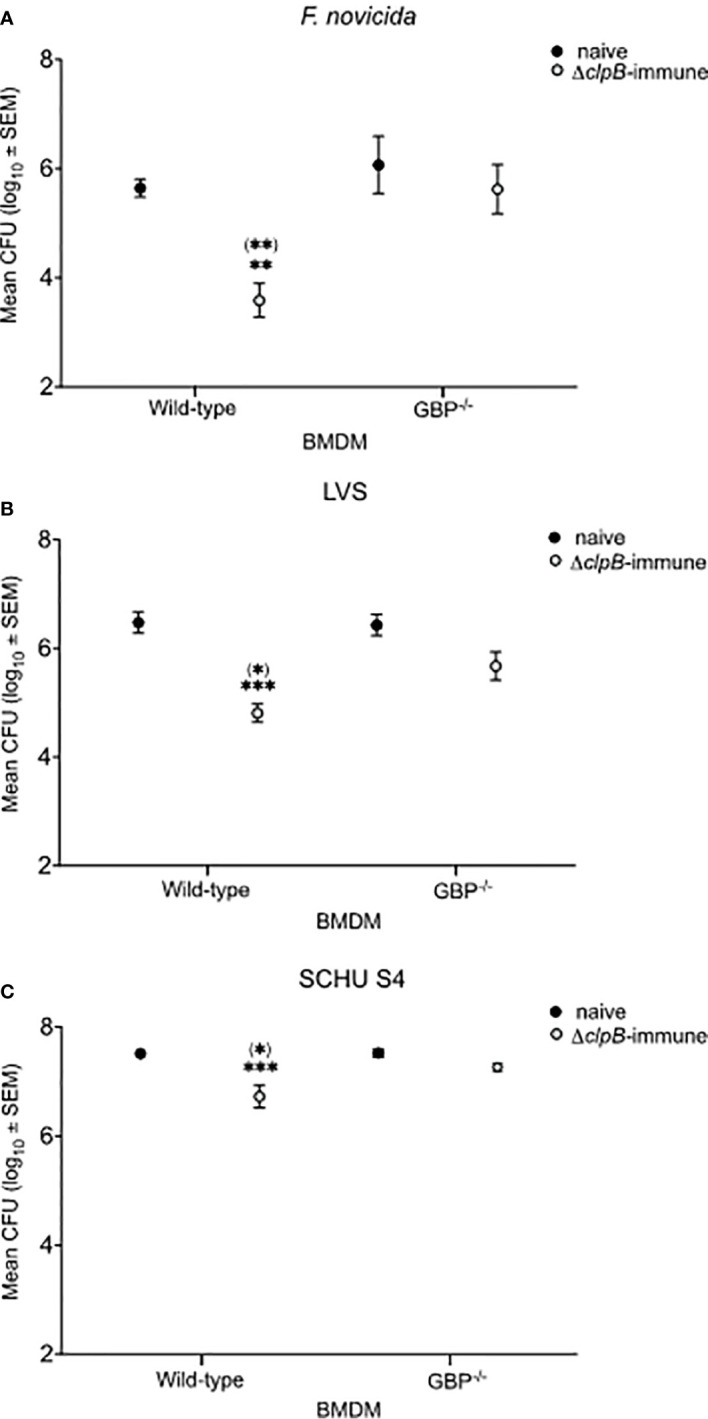
Intracellular replication of F. tularensis strains in the co-culture assay. BMDM monolayers were infected with (A)
F. novicida, (B) LVS, or (C) SCHU S4 and thereafter overlaid with splenocytes from either naïve or ΔclpB-immunized mice. Bacterial numbers were recorded after 72 h of infection. The bars represent CFU values from nine cultures generated in three separate experiments. Stars above the bars indicate significant difference in comparison to the values of cultures with wild-type BMDM and naïve splenocytes. Stars in brackets indicate significant differences vs. cultures with GBP
chr3−/−-deficient BMDM with ΔclpB-immune splenocytes.